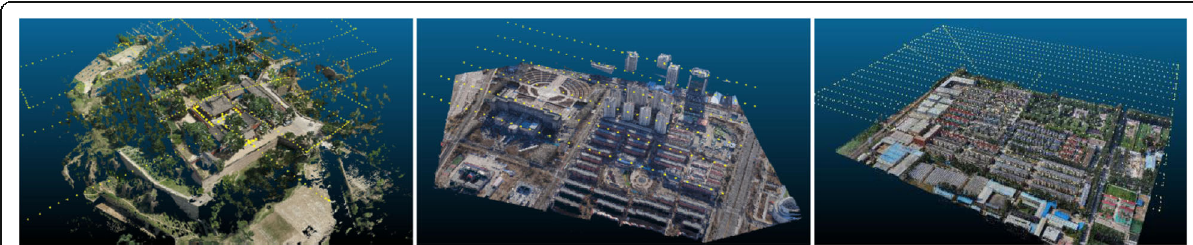
Fig. 4 Illustration of the point cloud and cameras of the Temple, City1 and City2 datasets; the yellow marks represent the positions of the cameras